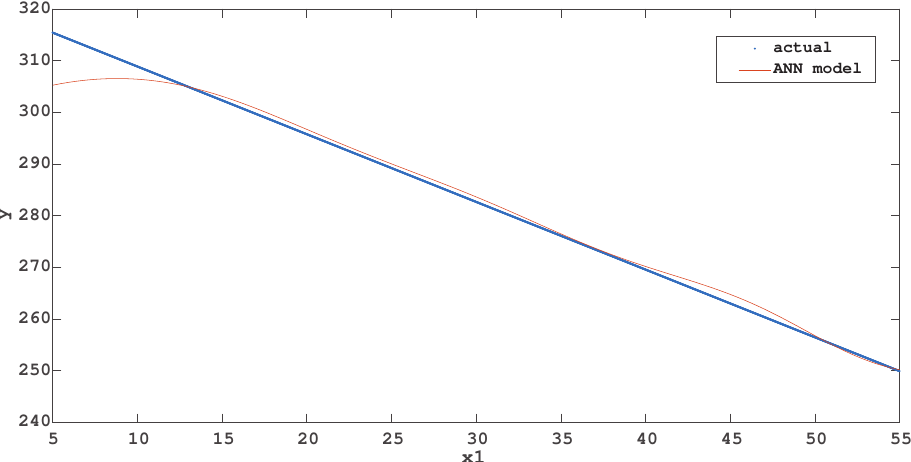
Figure 6. Comparison between actual and trained artificial neural network (ANN) model. Histogram of an error after training of an ANN is shown in Figure 7.